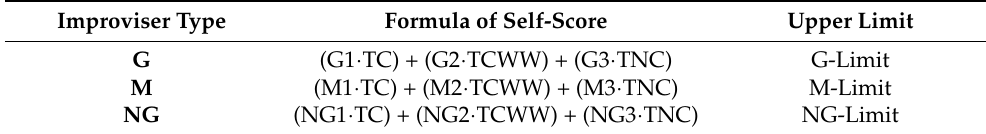
Table 2. Improvisers’ self-experience.